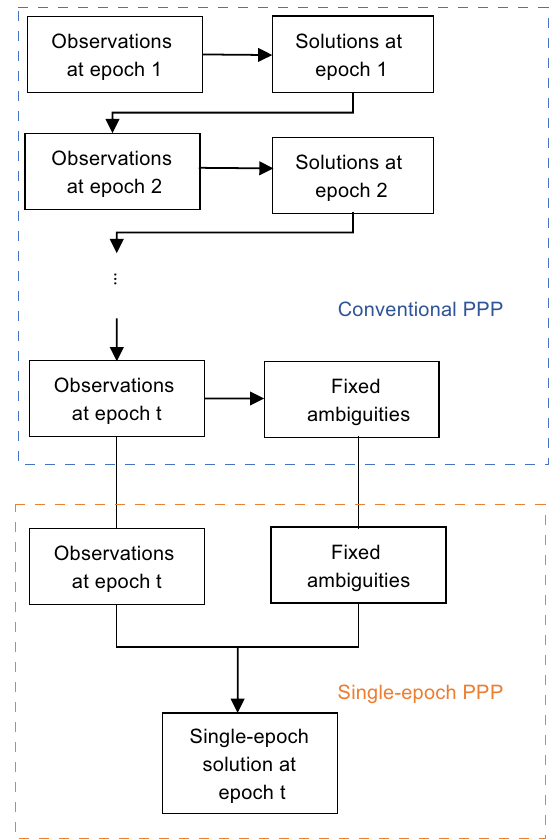
Fig. 1 Scheme for conventional PPP-RTK to single-epoch PPP-RTK framework